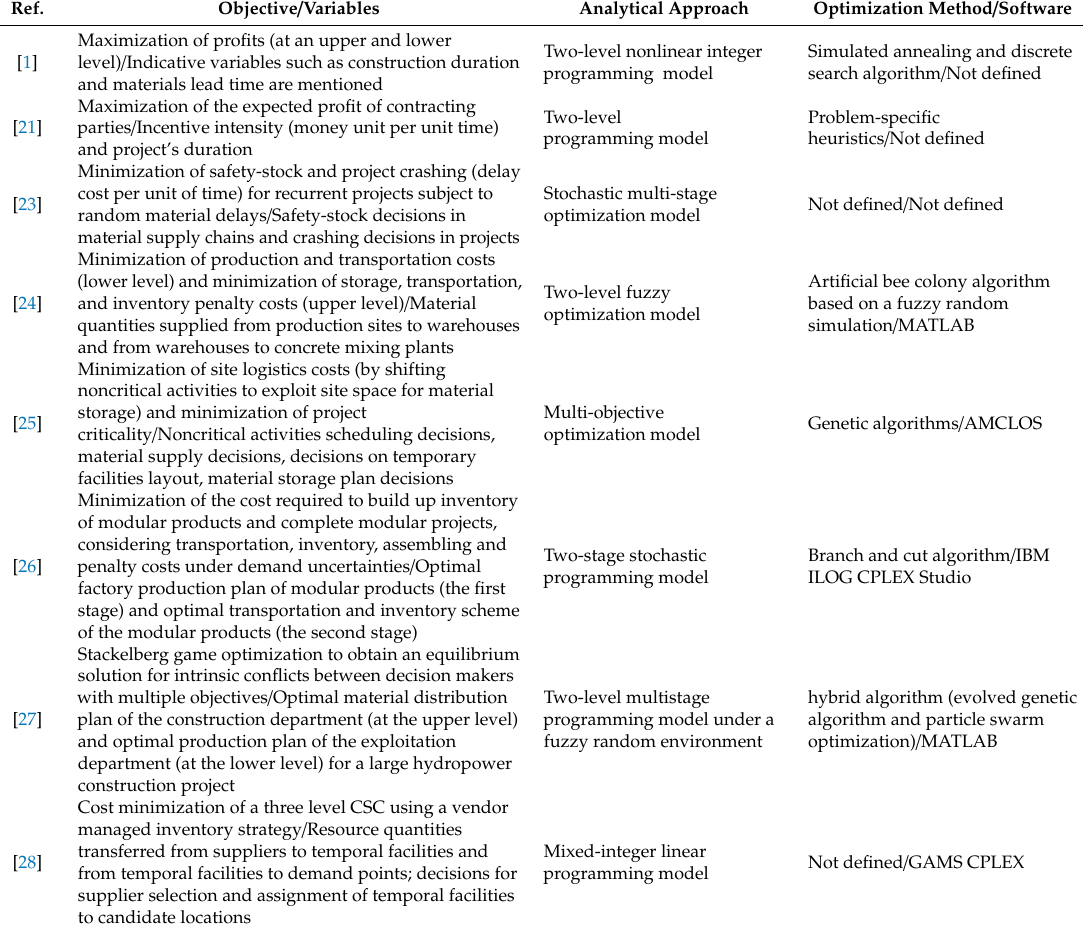
Table 1. Construction Supply Chain (CSC) optimization